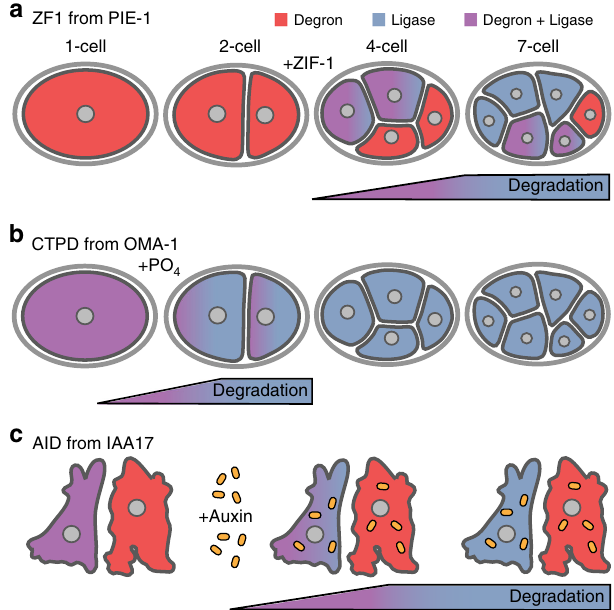
Fig. 1 Comparison of degron approaches. a Proteins with a zinc fi nger 1 degron (ZF1, red) are stable before expression of the ubiquitin ligase adaptor ZIF-1 (blue) in C. elegans embryos. ZIF-1 starts to be expressed in a stereotyped pattern of somatic cells after the two-cell stage, starting with the anterior cells (red + blue = purple). Proteins with a ZF1 tag are degraded in somatic cells, starting with the anterior cells (purple to blue). Cells that do not express ZIF-1, such as the posterior germ cell, do not degrade proteins with a ZF1 tag (red). b The C-terminal phosphodegrons (CTPD) of OMA-1 are inert until phosphorylated and CTPD-tagged proteins (red) are stable, despite the presence of SCF ubiquitin ligases (blue). Phosphorylation of CTPD occurs during the fi rst mitosis in C. elegans embryos, leading to degradation of CTPD-tagged proteins during the fi rst cell division. c Expression of the TIR1 ligase adaptor (blue) is not suf fi cient to induce robust degradation of proteins tagged with the auxin-inducible degron (AID, red). Addition of auxin family hormones induces degradation of AID-tagged proteins in cells where TIR1 is expressed (purple to